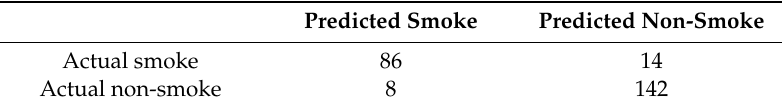
Table 1. Confusion matrix on test set.